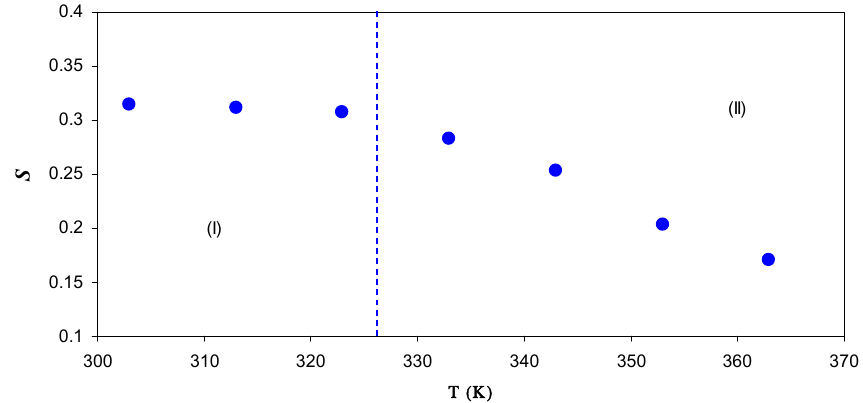
Figure 9. Temperature dependence of the frequency exponent ( S ) for SPE5 sample. Region I corresponds to QMT model, in which the s value almost temperature independent, whereas Region II reveals the dominance of CBH model.